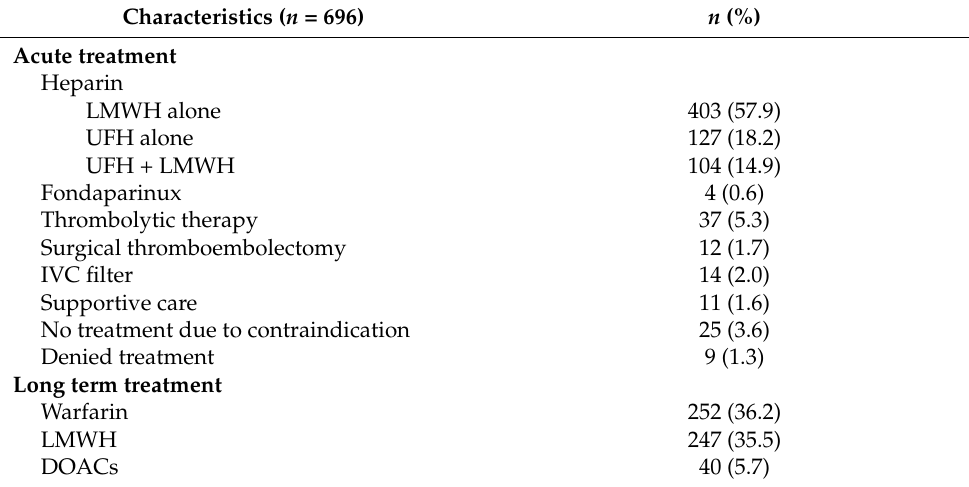
Table 3. Management of Patients with